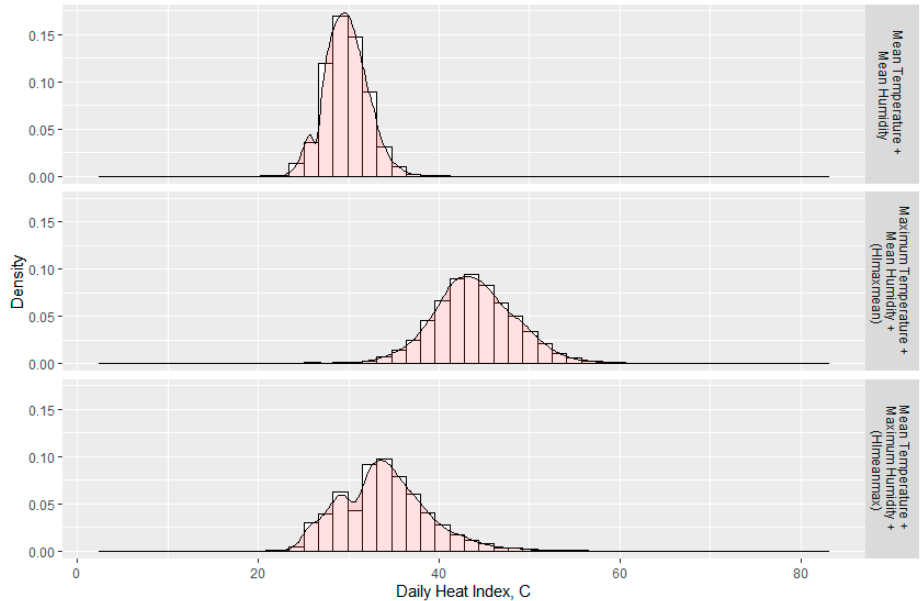
Figure 3. Distributions of all daily HI summaries calculated using three combinations of mean and maximum temperature and humidity, 2000–2014.